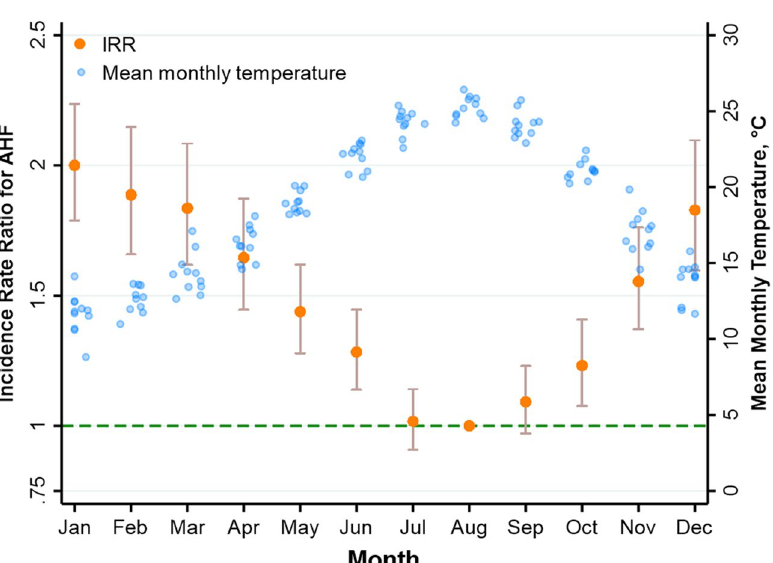
Figure 2. Results of a truncated negative binomial regression for AHF admission over 11 years (2005–2011). The annual pattern of incidence rate ratio (IRR, and 95% CI) is shown (with the reference group being August, the month with the lowest admission rates). The overlaid scatter plot shows the mean monthly temperatures recorded in each month (blue jittered circles) over the 11 years